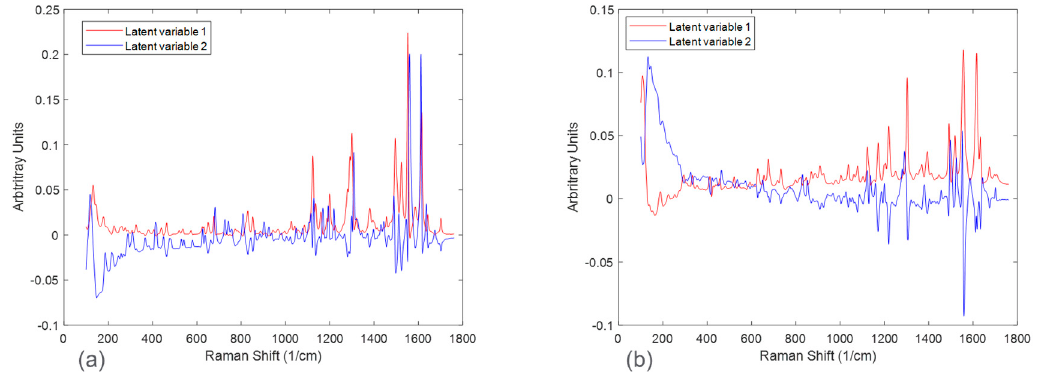
Figure 7. Latent variable plots of the calibration sets for HCl salt ( a ) and maleate salt ( b